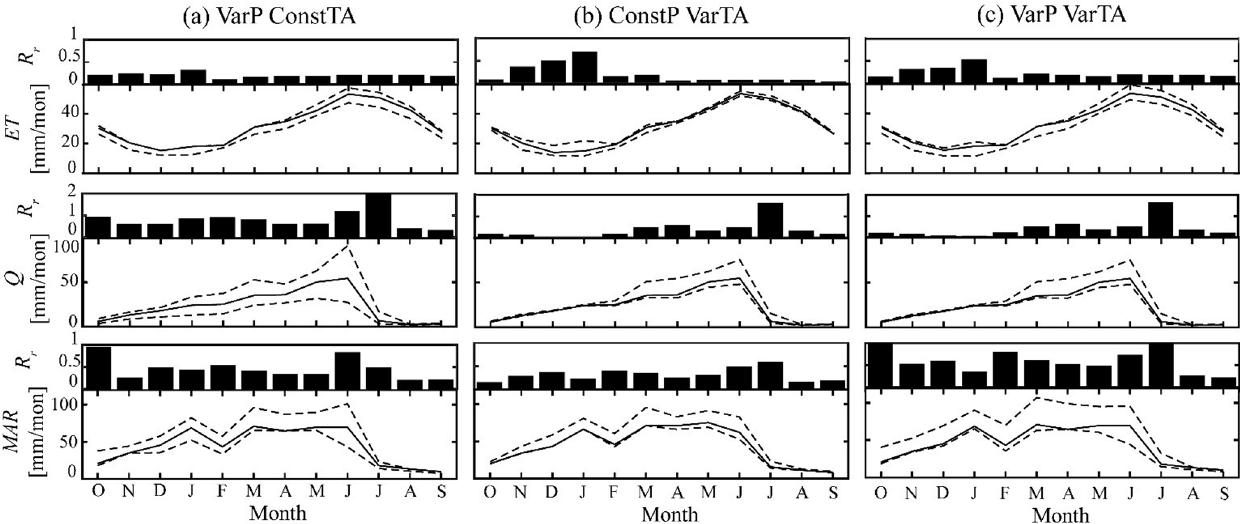
Figure 12. Monthly values of ET, Q , and MAR from the Kaweah Terminus watershed are presented for each of the three experiments (a) VarPConstTA, (b) ConstPVarTA, and (c) VarPVarTA for WY2016. The solid lines represent the values from the base case scenario, while the dashed lines present the range of values from the scenarios included in each experiment. Bars represent the relative range ( R r ) , defined as the range of simulated values for each experiment divided by the monthly value from the base